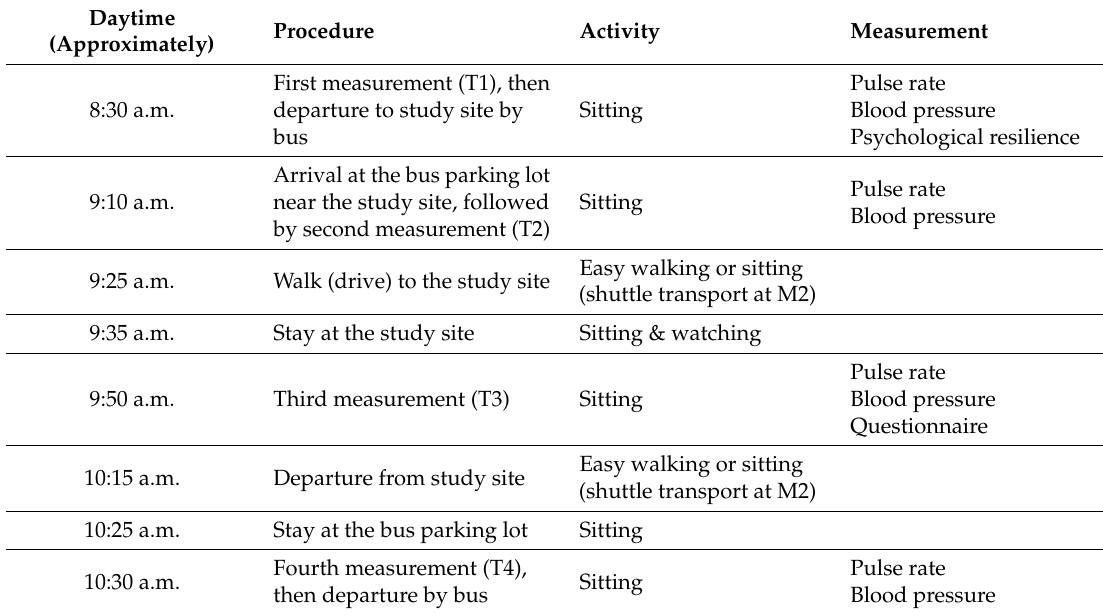
Table 1. Detailed daily data collection